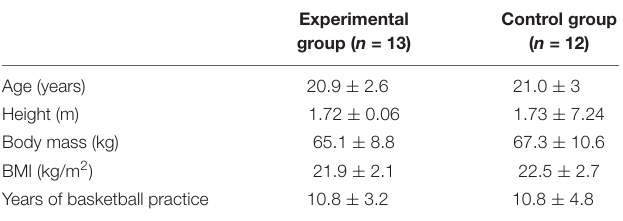
TABLE 1 | Initial characteristics of experimental and control